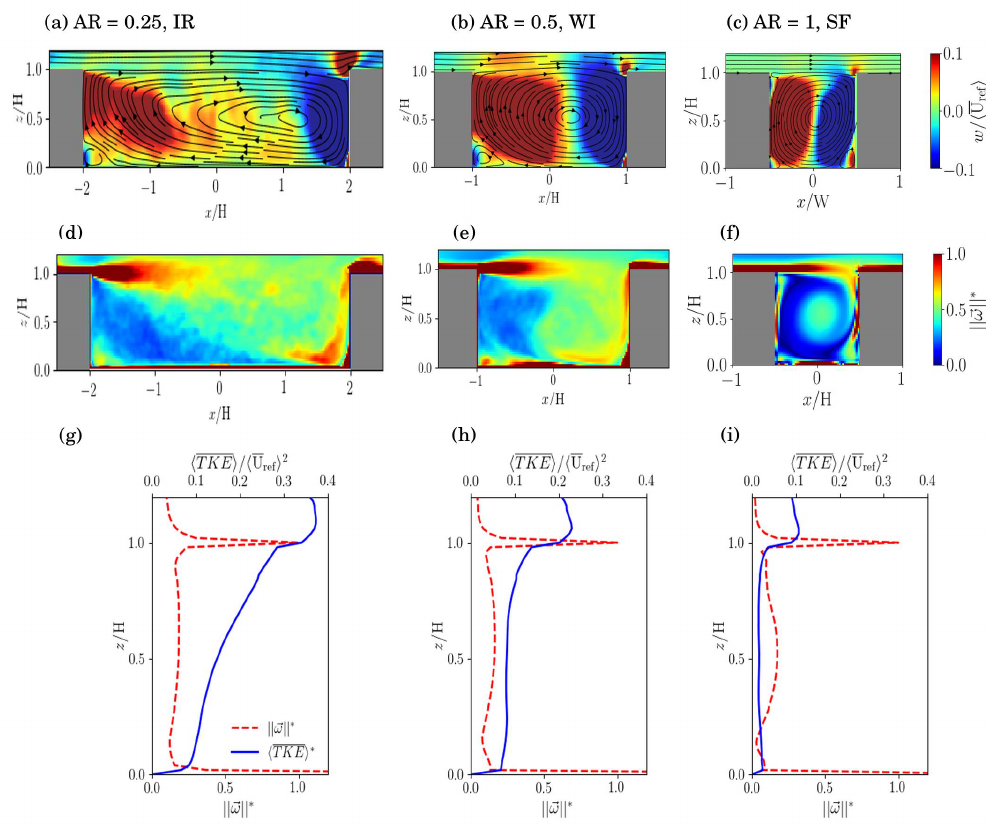
z plane for uniform street canyons with a mean flow perpendicular Figure 4. Flow structures in the x − to the canyon axis ( θ = 0°): ( left ) AR = 0.25; ( middle ) AR = 0.5; ( right ) AR = 1. ( a – c ) Temporally and spatially averaged streamlines; vertical velocities are plotted in colour; ( d – f ) spatially averaged (cid:126) ω vorticity magnitude normalised by the maximum value, ; ( g – i ) vertical profiles of the TKE and || || ∗ ¯ U (cid:126) ω = 1. . The TKE is normalised using ref (cid:105) , the IDDES streamwise velocity at z / H || || ∗ (cid:104) The estimated and true wind profiles for θ = 0° are compared in Figure 5. For all three regimes, there is very good agreement in the interior, but large deviations at the bottom, where the log profile is applied. The canyon-averaged relative errors satisfy ε r 0.30 and ∼ 0.13 for u x and u y , respectively, while ε a 0.017 for the absolute errors. Similar results are ∼ [ 0°, 90° ] except for u = 90°. The reasons for this are discussed obtained for other θ y at θ ∈ in Section